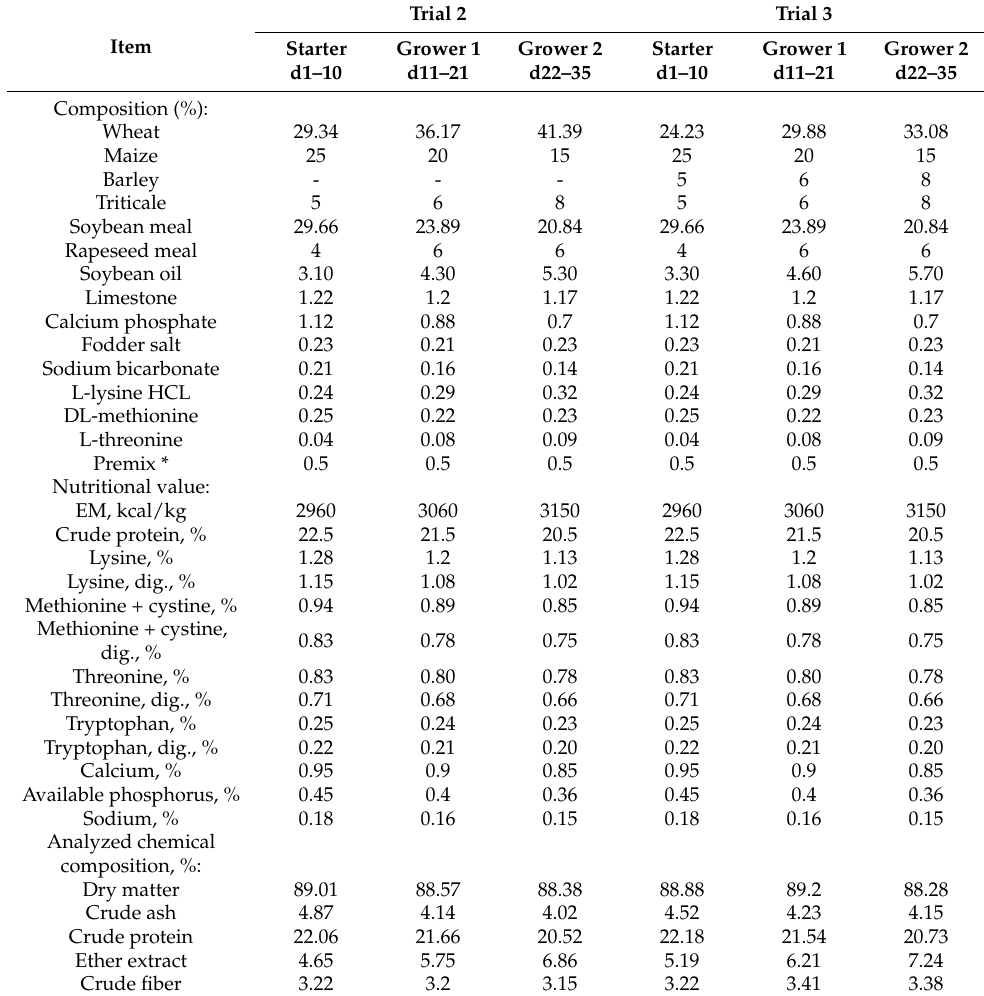
Table 2. Composition and nutritional value of basal diets for trials 2 and